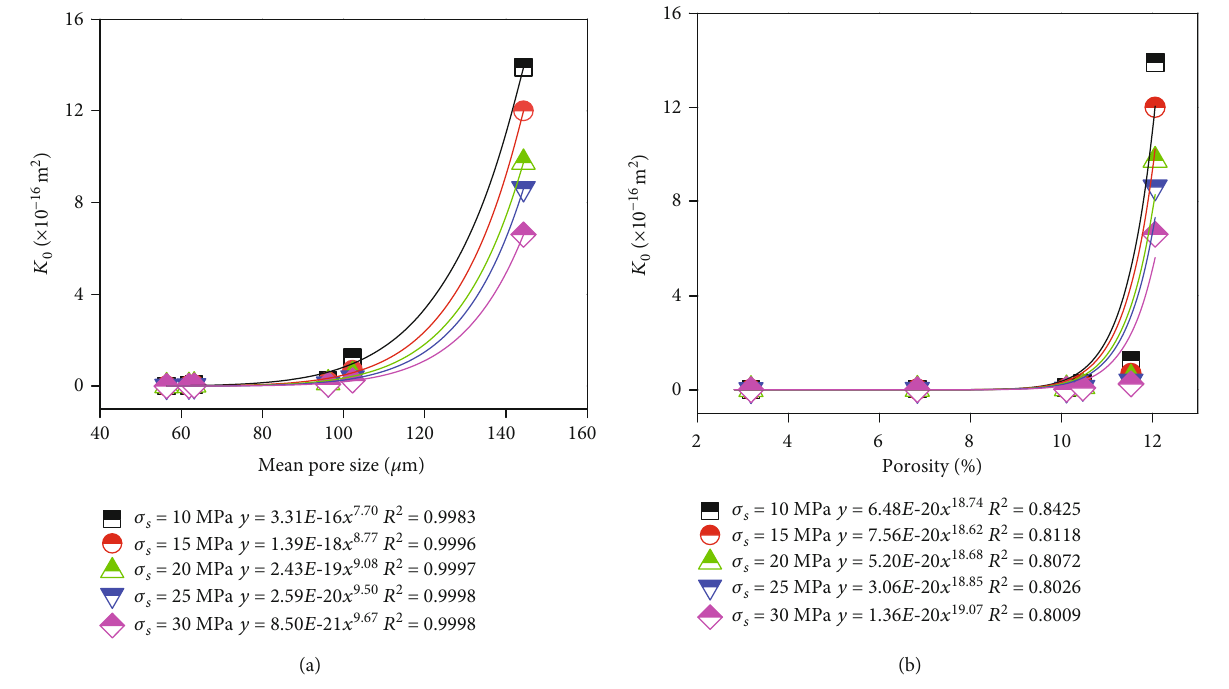
Figure 6: Relation of equivalent permeability coe ffi cient with mean pore size and